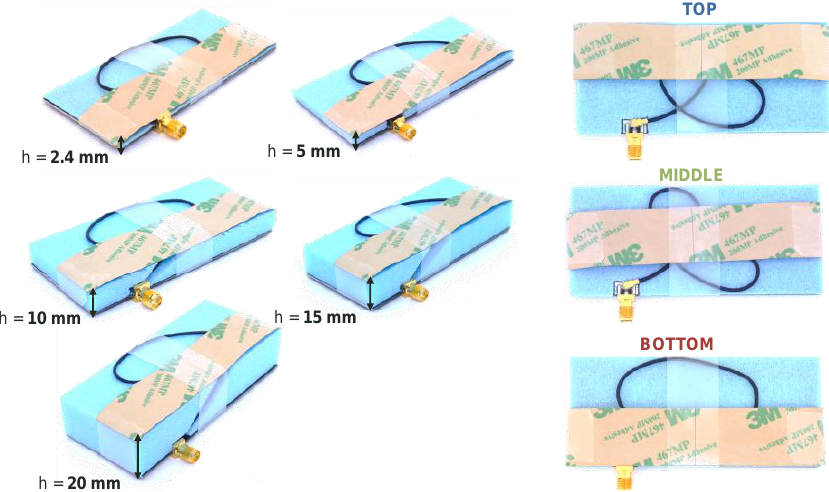
Figure 9. FPC antenna on a 95 mm × 42 mm PCB at several heights (2.4 mm, 5 mm, 10 mm, 15 mm, and 20 mm) and for three different positions on the PCB.